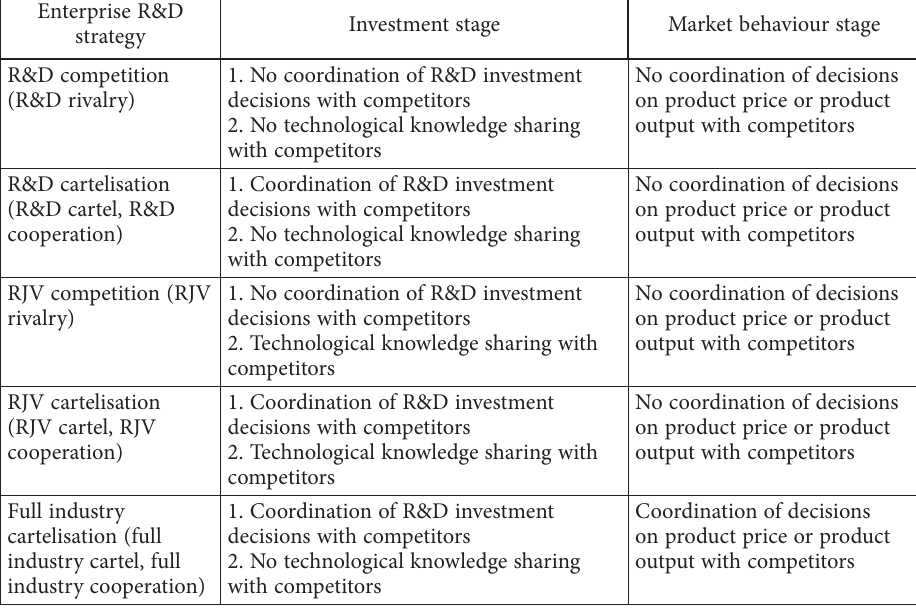
Table 1. Types of enterprise R&D strategies Enterprise R&D Investment stage Market behaviour strategy